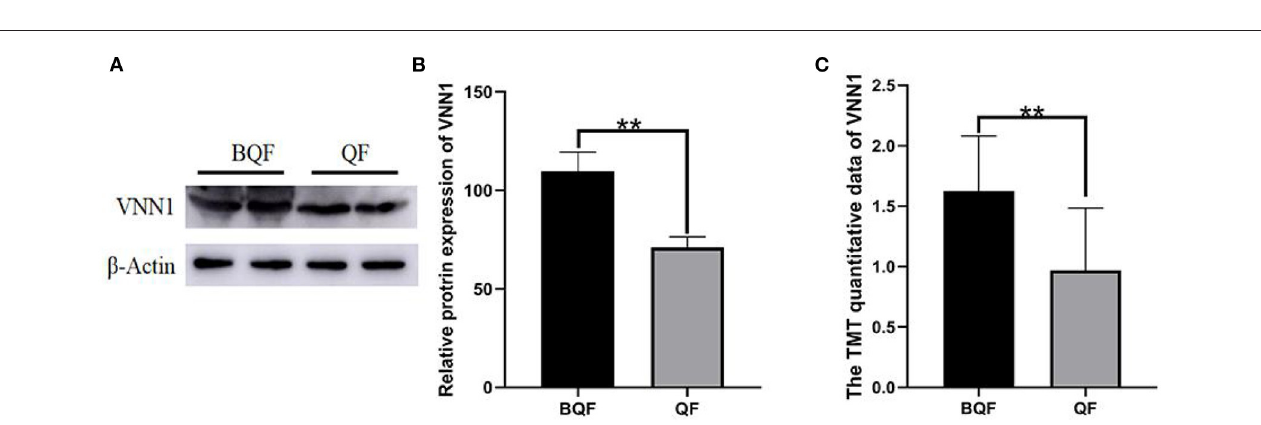
FIGURE 9 | Validation of VNN-1 by immunoblot analysis. (A) Representative immunoblotting of DEPs between subclinical VE deficiency cows (QF) and controls (BQF). (B) Quantification of relative gray values of VNN-1 compared with actin (** p < 0.01). (C) The TMT quantitative data of VNN1 between QF group and BQF (** p < 0.01).